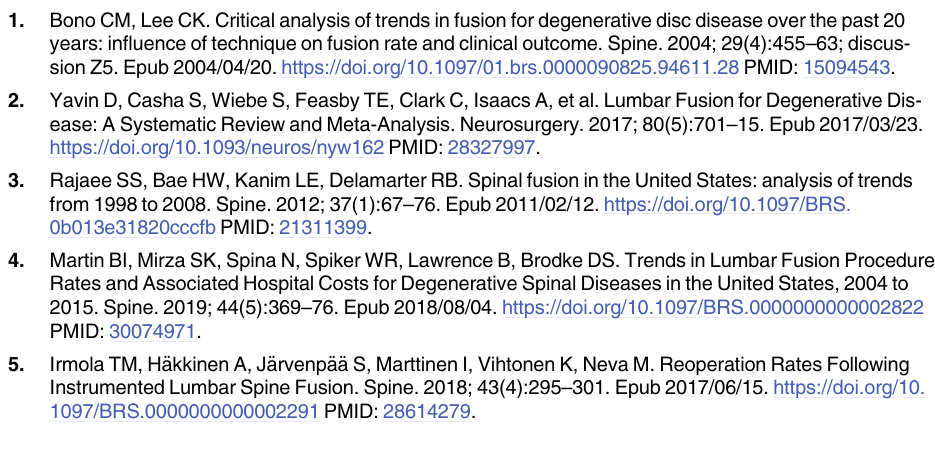
S1 Fig. Funnel chart analysis of multiple indicators. S2 Fig. Sensitivity analysis of multiple indicators. S3 Fig. Heterogeneity tests by forest plots. S1 File. S1 Table. Observation time nodes of different observation indexes in the 24 studies. S2 Table. Meta-regression analysis of observation time nodes in this